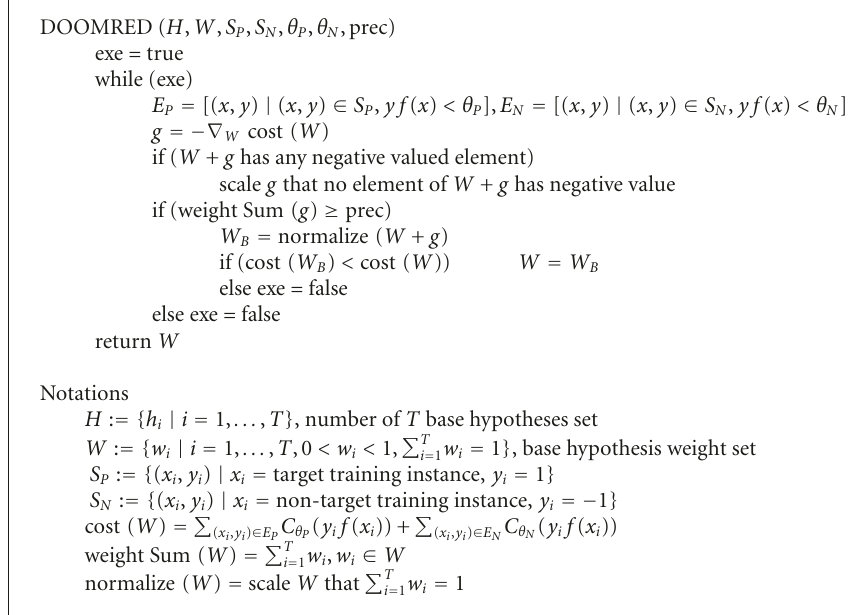
Algorithm 1: The pseudocode of